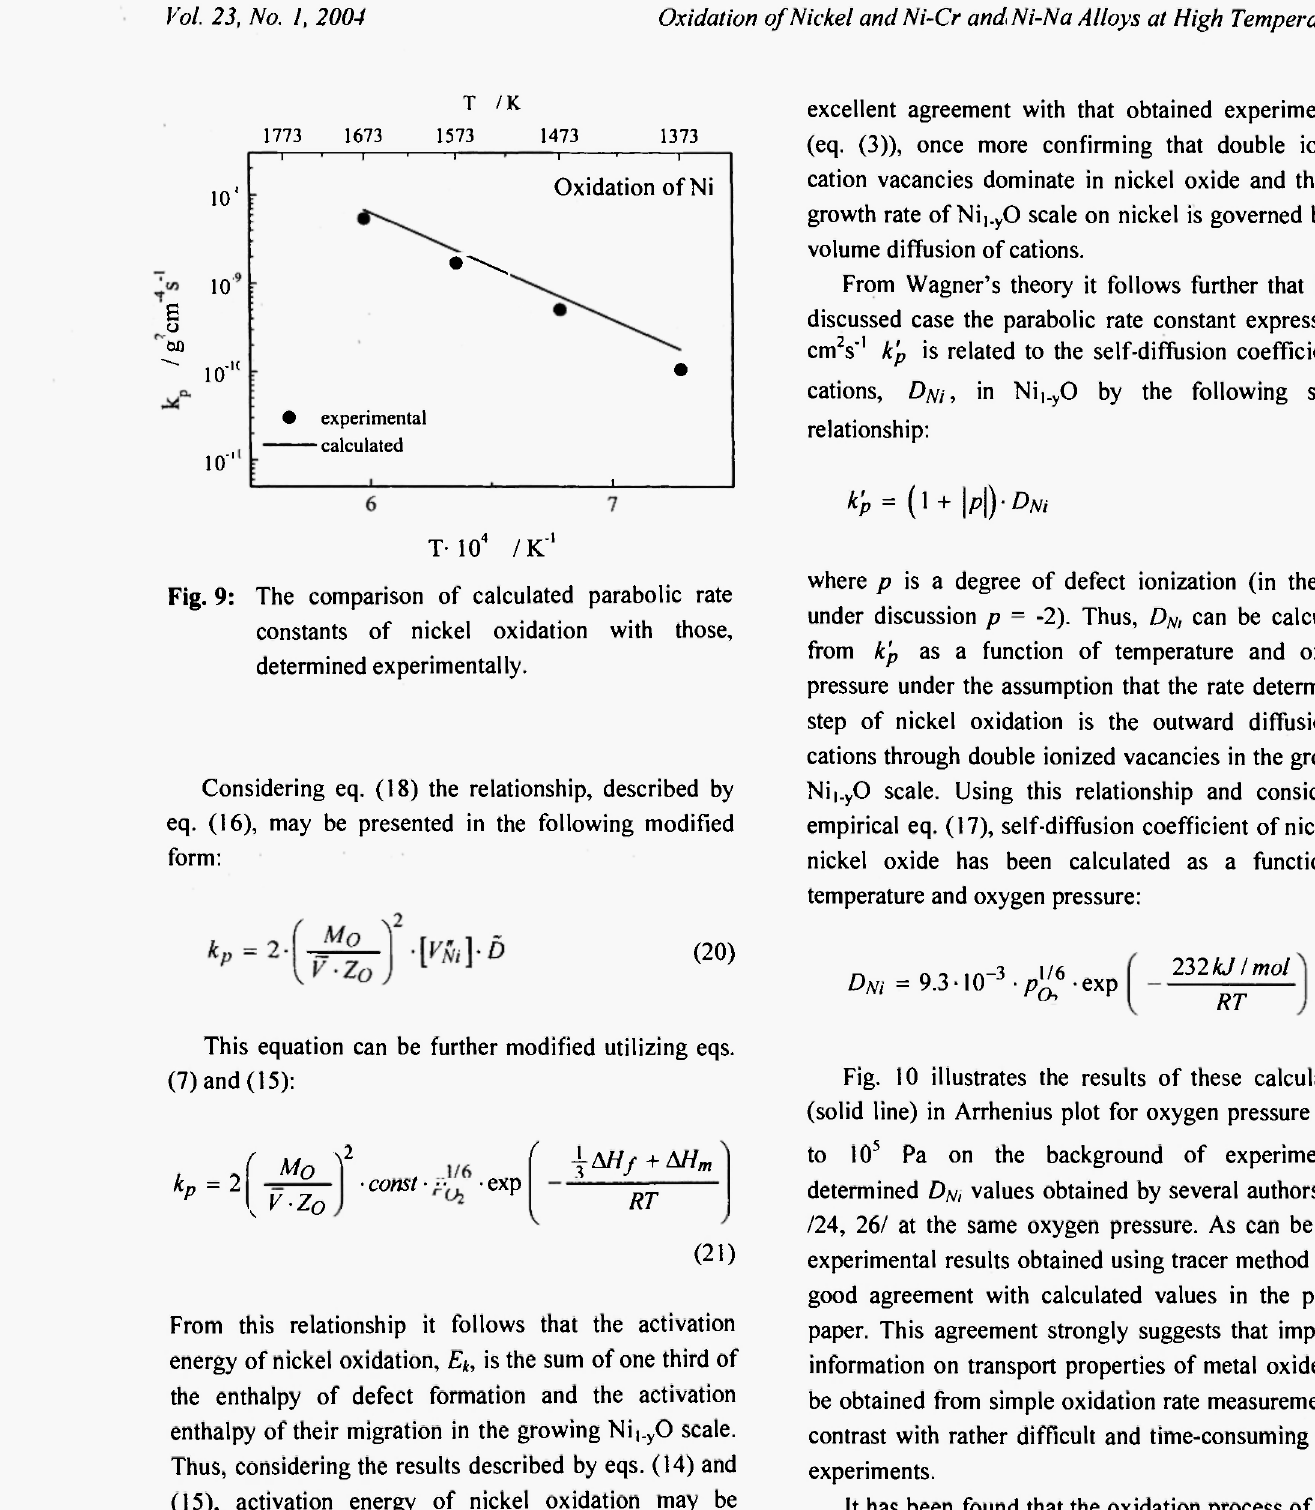
Fig. 9: The comparison of calculated parabolic rate constants of nickel oxidation with those, determined